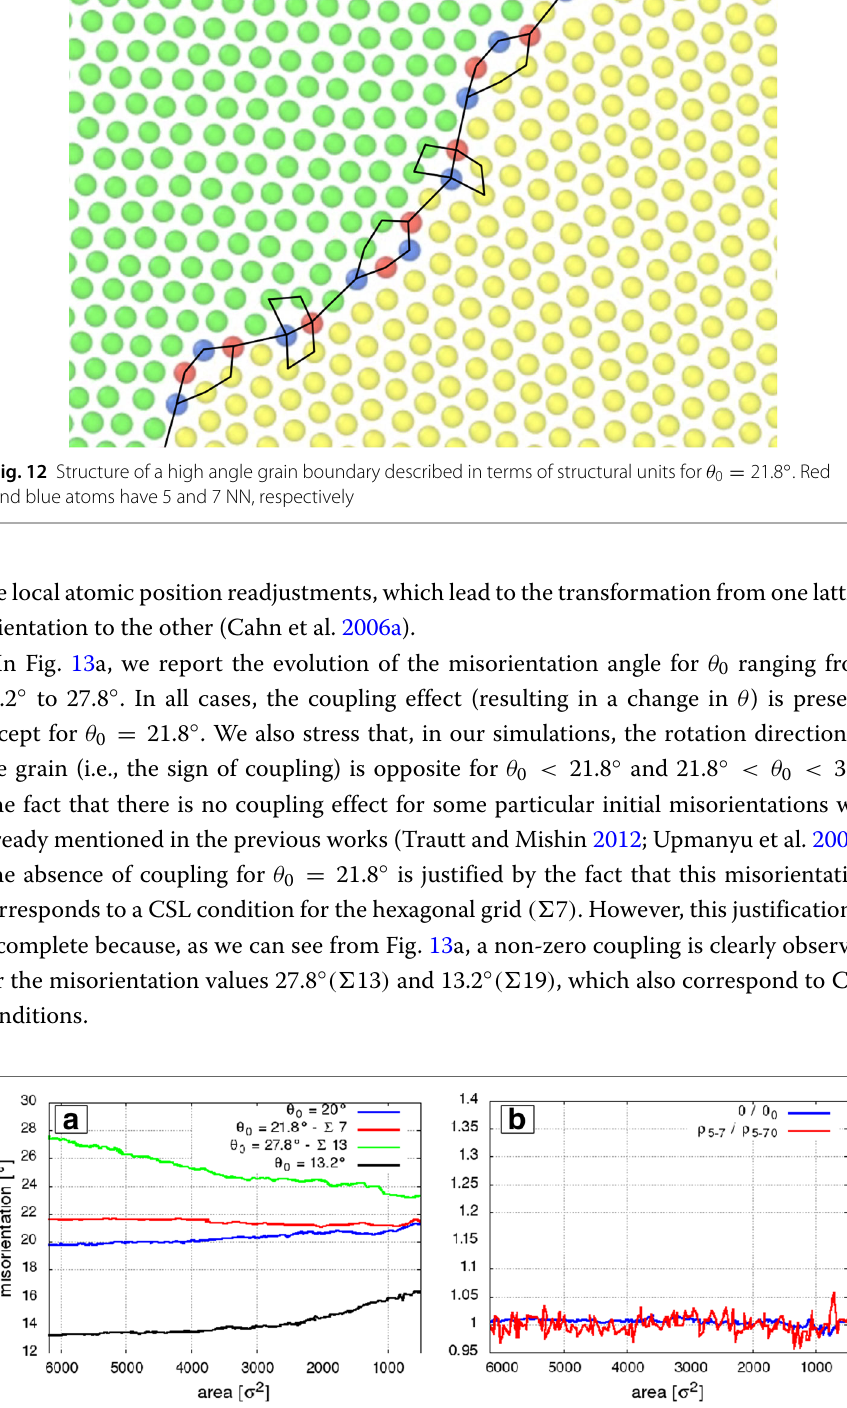
Fig. 13 a Misorientation as a function of the grain area (in σ 2 units) for several initial misorientation θ 0 ; b 5-7 along the grain boundary (red curve) and change in the misorientation angle θ/θ 0 pairs density ρ 5 − 7 /ρ 5 − 7 0 (blue curve) during grain shrinkage for the initial misorientations θ 0 = 21.8